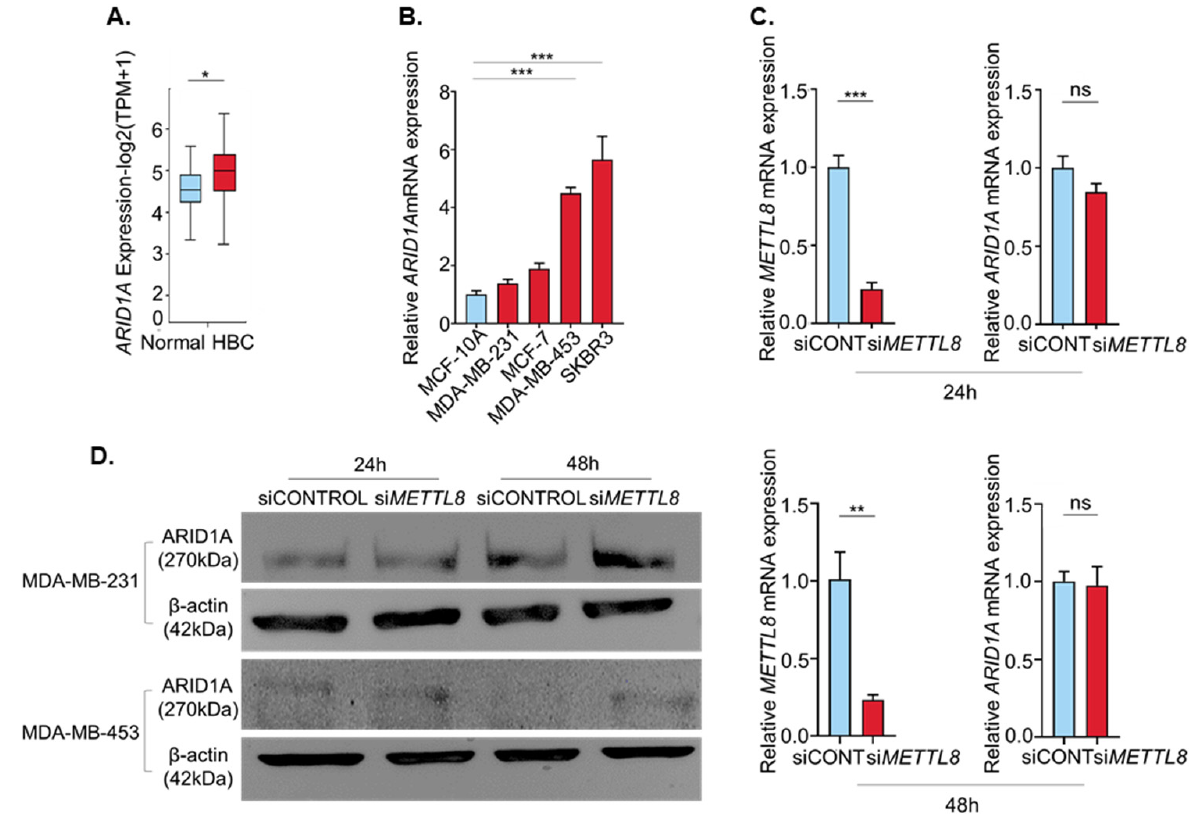
Figure 5. ( A ) Boxplot showing relative expression of ARID1A in breast cancer. ( B ) Total RNAs were extracted from MCF-10A, MDA-MB-231, MDA-MB-453, and SKBR3 cell lines and subjected to RT-qPCR analysis for ARID1A. ( C ) ARID1A mRNA levels were not changed by METTL8 knockdown. METTL8 and ARID1A mRNA levels were analyzed by RT-qPCR at 24 h and 48 h after the METTL8 knockdown in MDA-MB-231 cells. ( D ) ARID1A protein expression levels were increased after METTL8 knockdown. Western blots were subjected to detect ARID1A protein expression 24 h and 48 h after METTL8 siRNA transfection in MDA-MB-231 cells and MDA-MB-453 cells. * indicates p < 0.05, ** p < 0.01, and *** p < 0.001, HBC: human breast cancer.